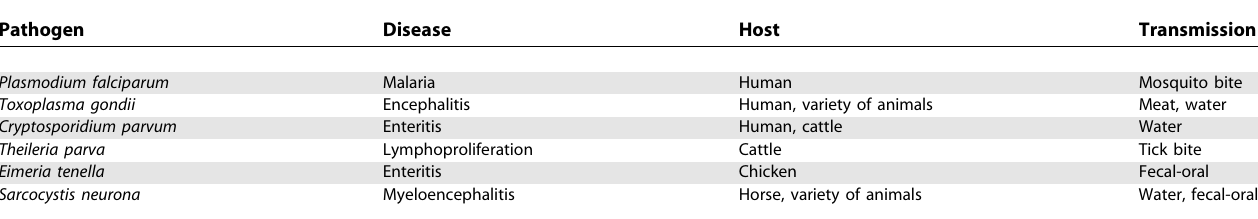
Table 1. Apicomplexan